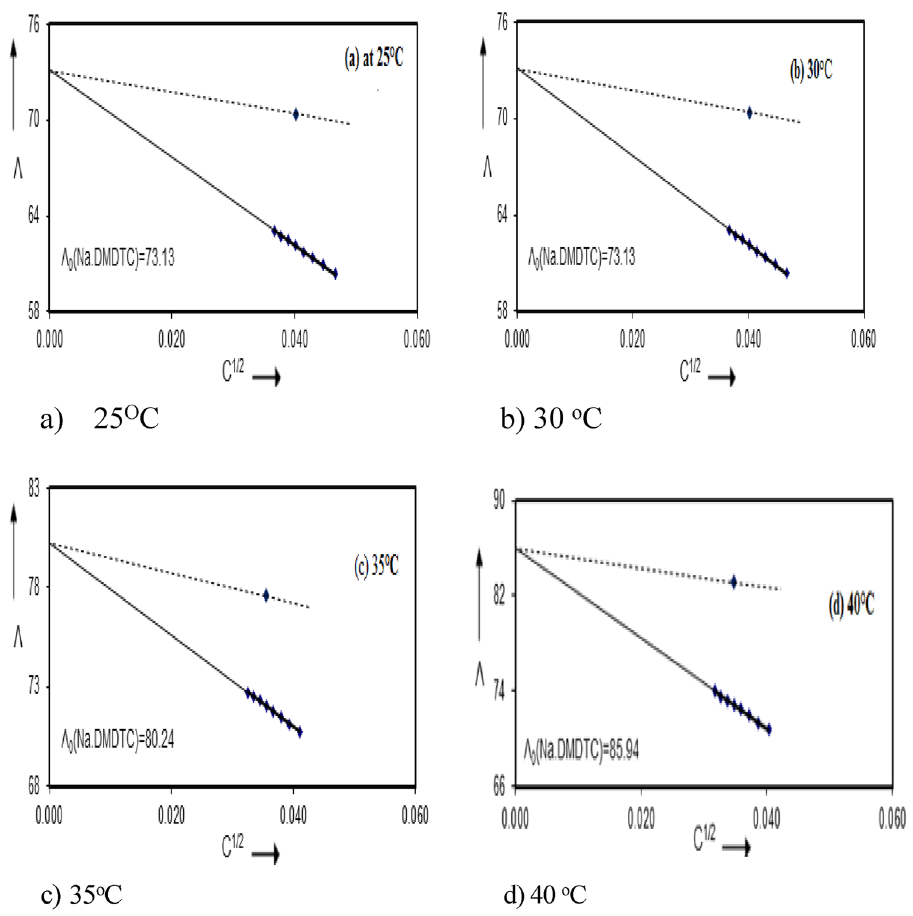
Figure 2. Conductance of Sodium N , N Dimethyl dithiocarbamate in Dimethylformamide at ( a ) 25, ( b ) 30, ( c ) 35 and ( d ) 40